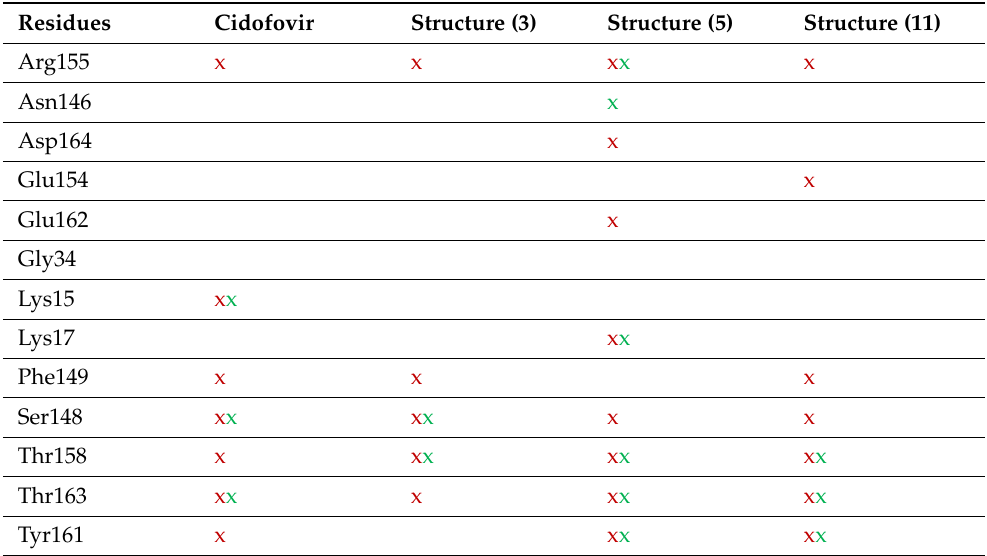
Table 2. Showing the interacting residues of cowpox CPXV203 protein (D Chain) with cidofovir and the best